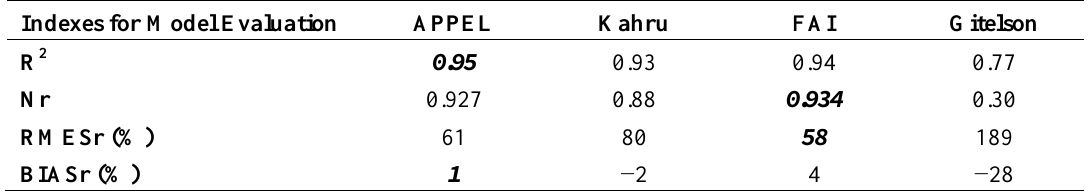
Table 3. Model performance using cross-validation results for the data subset Chl-a >50 mg∙m –3 .